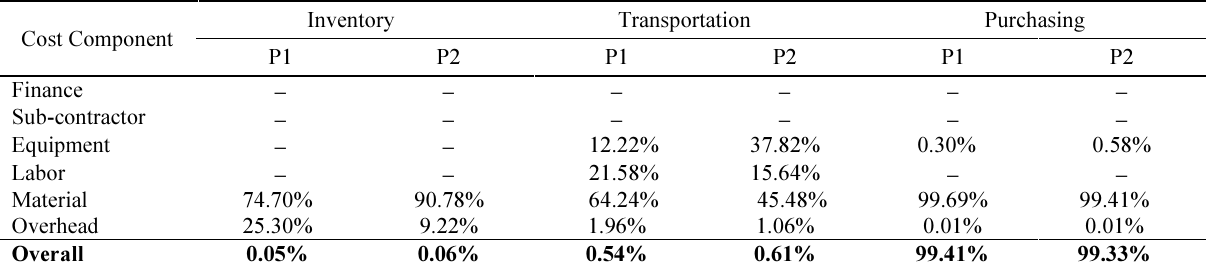
Table 1. Percentage of rebar’s supply chains cost components Cost